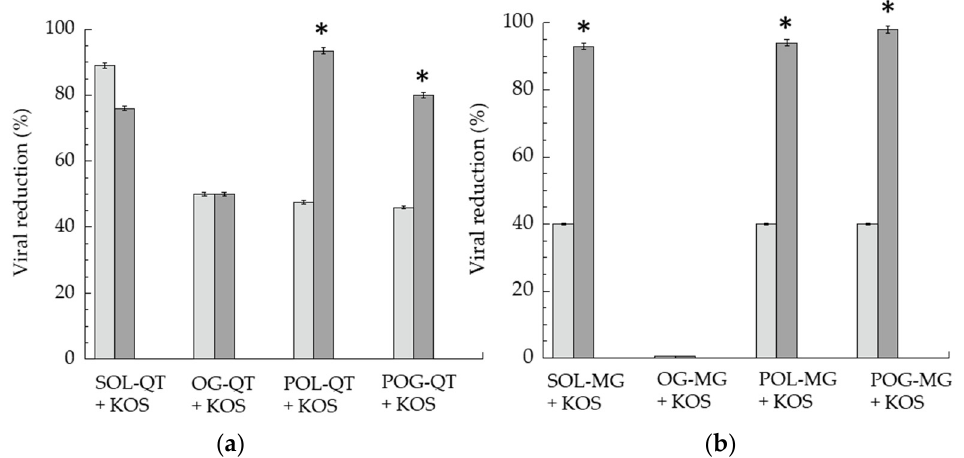
Figure 6. Virucidal activity of QT-containing ( a ) and MG-containing ( b ) formulations, expressed as percentage of viral reduction measured after 1 (light gray) and 6 (gray) h of contact between formulations and KOS strain at 35 °C. Data represent the mean of 3 independent experiments, * P values < 0.05.